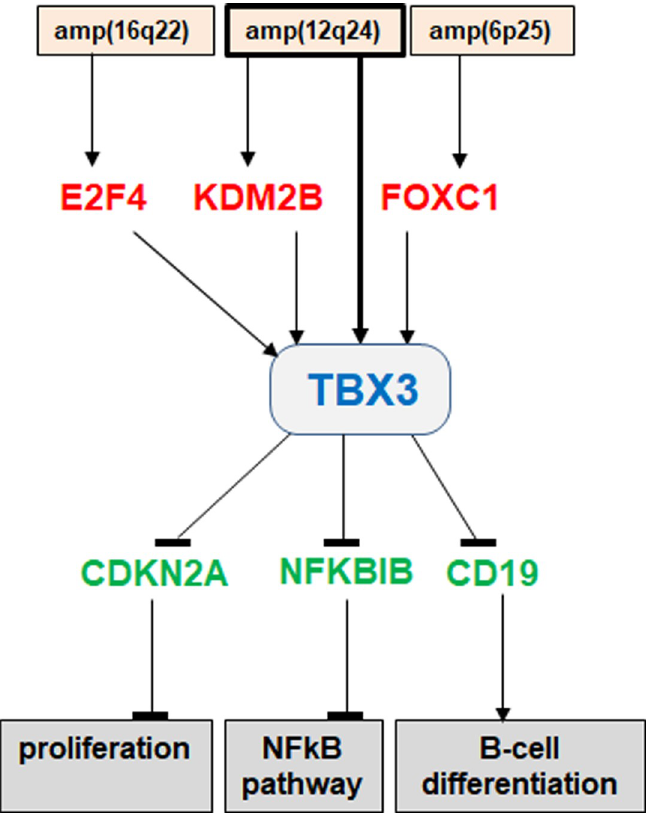
Fig 7. Gene regulatory network around TBX3 in HL. This diagram summarizes the results of this study, placing TBX3 at the centre of an aberrant gene regulatory network. TBX3 is directly targeted by genomic amplification just like its activators E2F4, KDM2B and FOXC1. TBX3 inhibits expression of CDKN2A, NFKBIB and CD19, thereby impacting proliferation, NFkB-signaling and B-cell differentiation, respectively.